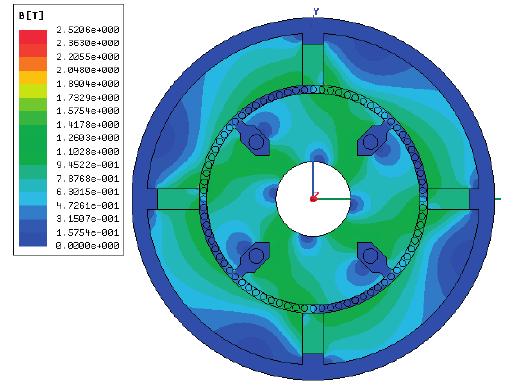
Figure 11. Distribution of magnetic flux Ф .